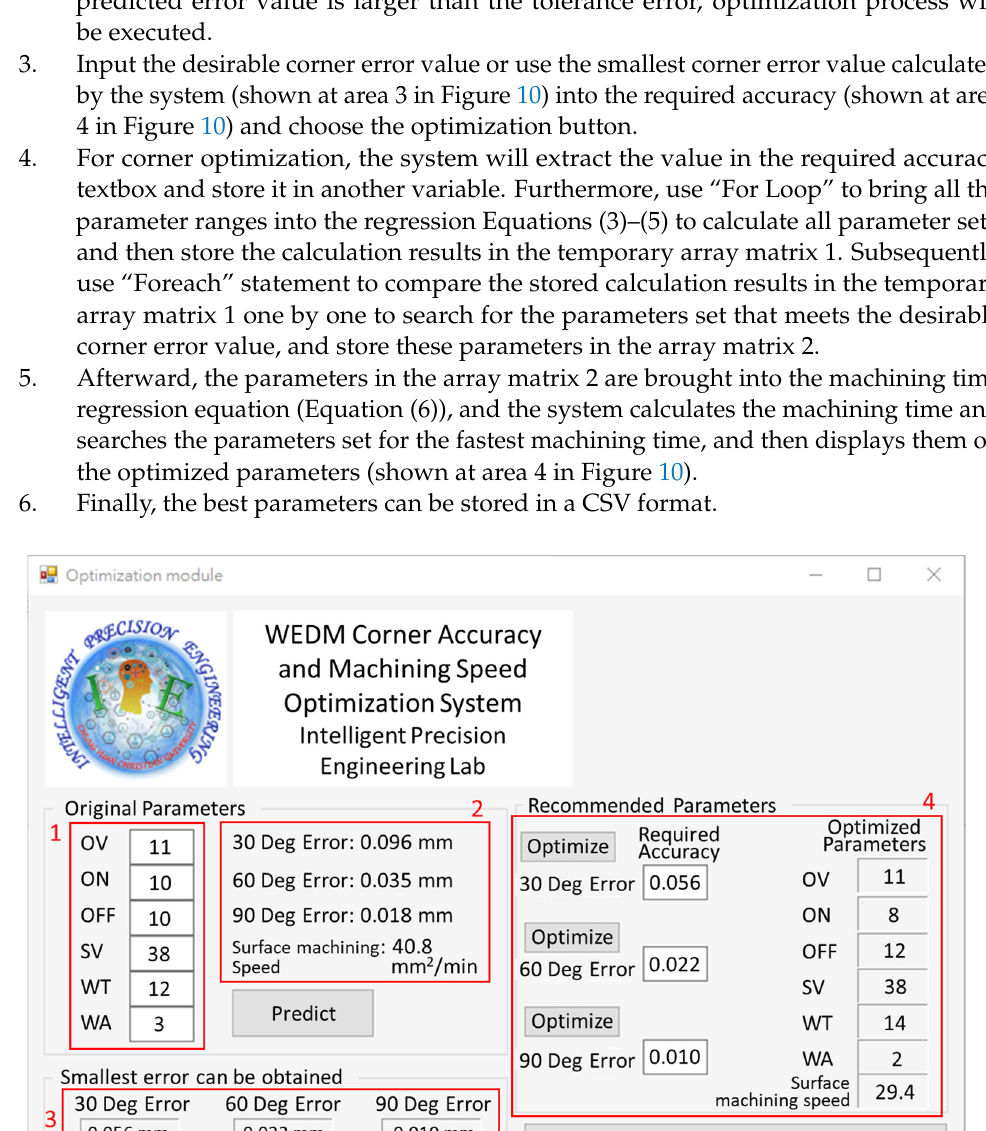
Table 12. Original parameters and optimized parameters obtained from the developed optimization system.